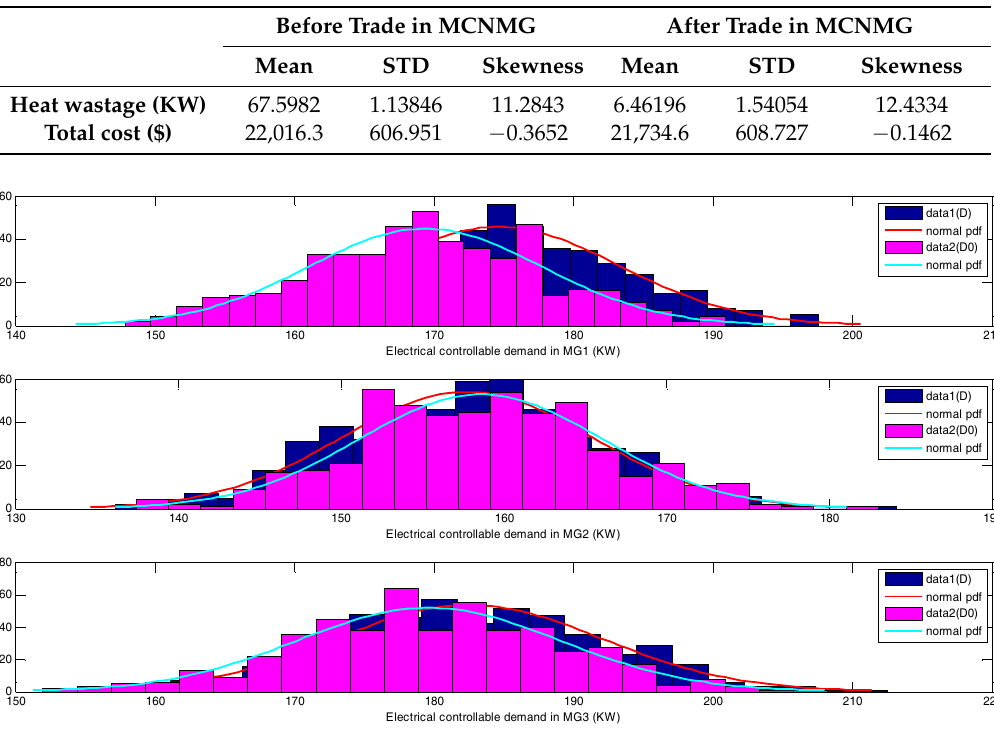
Figure 9. PDF of electrical responsive load profile under TOU policy in MCNMG. Top: MCMG1; Middle: MCMG2, Bottom: MCMG3.